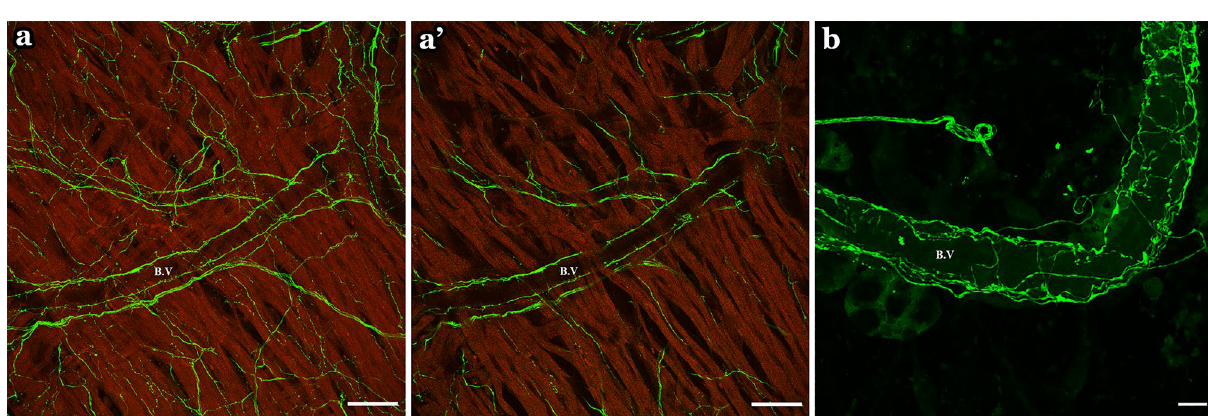
Figure 13. TH-IR axons innervated the blood vessels (B.V). ( a ) Partial projection image showed TH-IR axon innervation along and around the blood vessels. ( a’ ) A single optical section of the image in a showed TH-IR axons innervating the cardiac muscle. ( b ) showed TH-IR axons innervating the blood vessels. Red Autofluorescence . Scale bar: 50 μm (in ( a , a’ )) 10 μm (in ( b